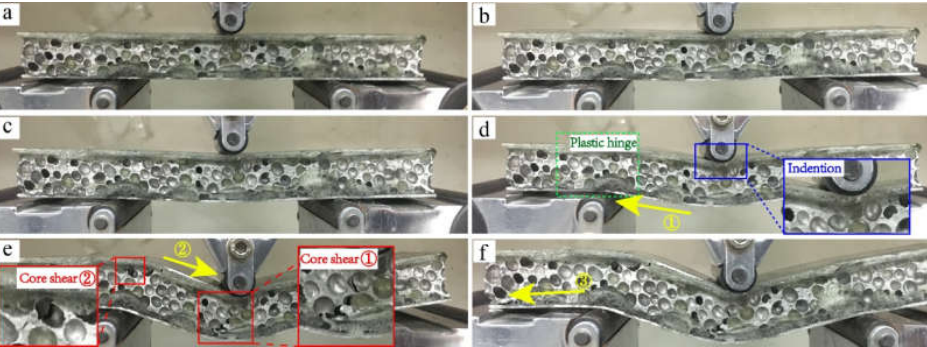
Figure 9. Deformation process from ( a ) to ( f ) of AFS after interface enhancement under three-point bending. Table 4. Peak load, displacement, effective displacement and energy absorption of each